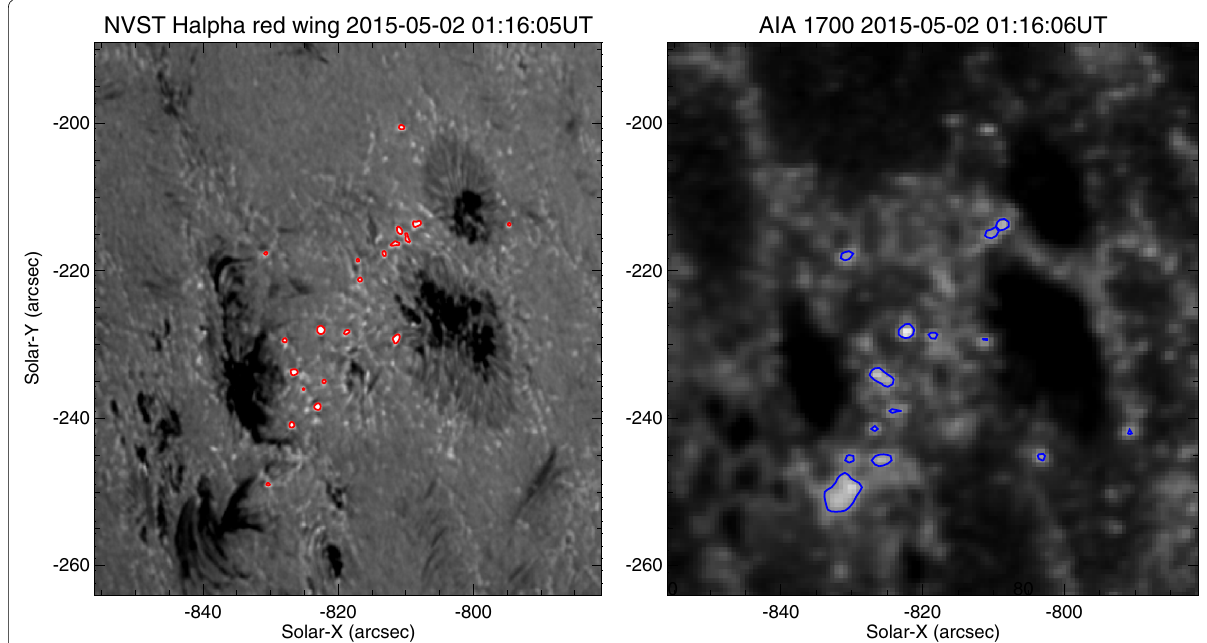
Fig. 1 Images of Hα red wing (left panel) and 1700 Å (right panel) taken at 01:12 UT on 2015 May 2. The red and blue contours mark the brightest pixels in the Hα red wing and 1700 Å images, respectively, using the intensity thresholds mentioned in “Observations and data analysis”